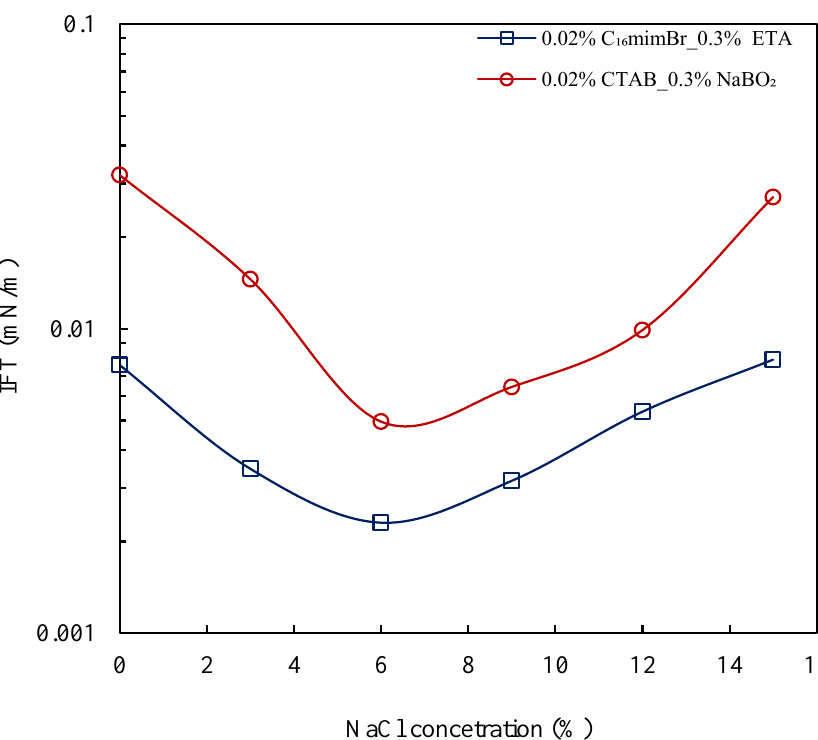
Figure 10. Salinity effect on IFT reduction by AS formulations at 25 °C.